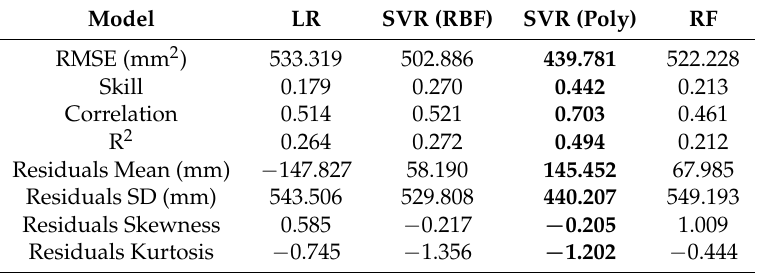
Table 5. Performance of each of the winter precipitation models on the testing data set (2011–2019), similar to Table